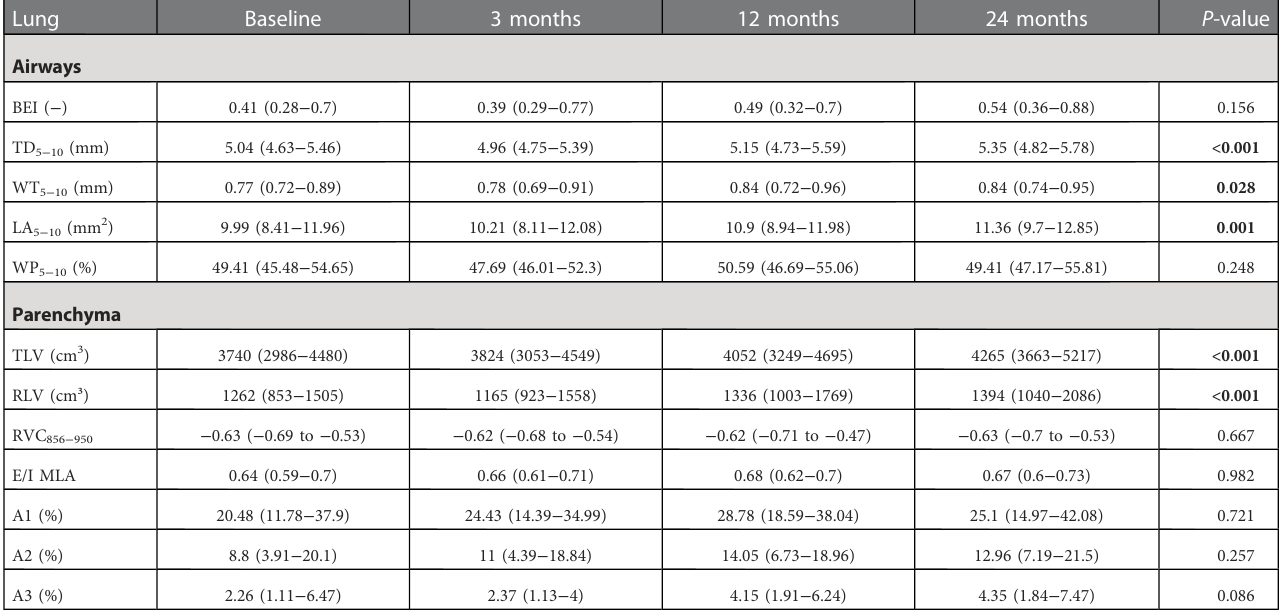
TABLE 2 Temporal development of airway and air trapping parameters. Airway parameters (BEI, TD, WT, LA, and WP), TLV, RLV and air trapping parameters (RVC856-950, E/I MLA, A1-3) were calculated for the whole lung at baseline, 3 months, 12 months, and 24 months. Airway parameters refer to the subsegmental airways generations